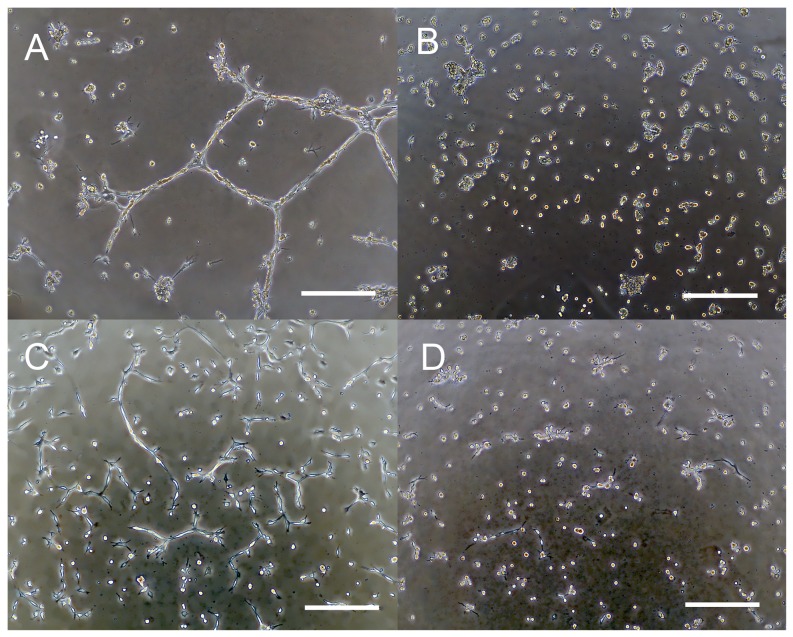
The findings of the three-dimensional culture of SCLs.Cells were incubated for 12(A and B) or 24 hours (C and D). SCLs proliferated linearly and formed tube-like structures and network-like structures within Matrigel (A), but the A549 (lung adenocarcinoma) cells formed no network structures (B). SCLs incubated with EBM-2 also formed the tube-like structures in the Matrigel (C). Exposure to 10 µM batimastat inhibited the formation of the three-dimensional structures (D). (Scale bars show 300 µm.)